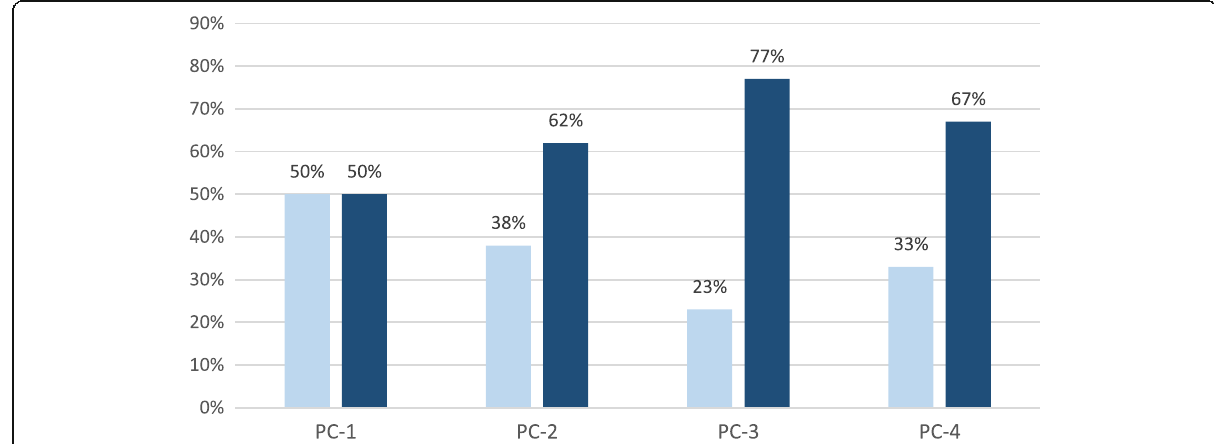
Fig. 2 Percentage of publications in single-disciplinary (light color bars) and cross-disciplinary (dark color bars) concentrations for each publication cycle